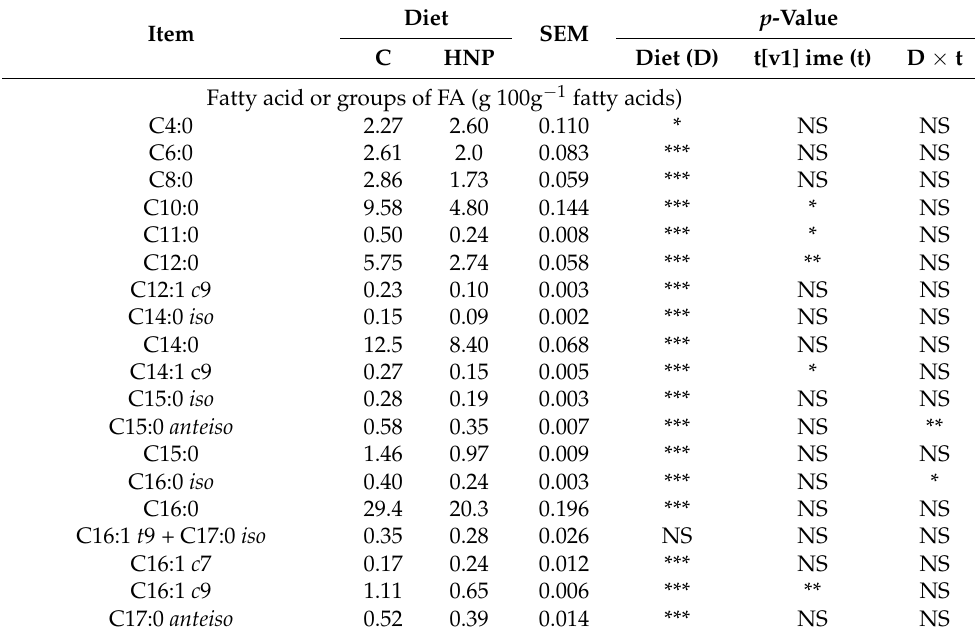
Table 3. Fatty acid profile, tocopherols, Degree Antioxidant Protection (DAP), and nutritional indices of cheese from ewes fed control and hazelnuts peel